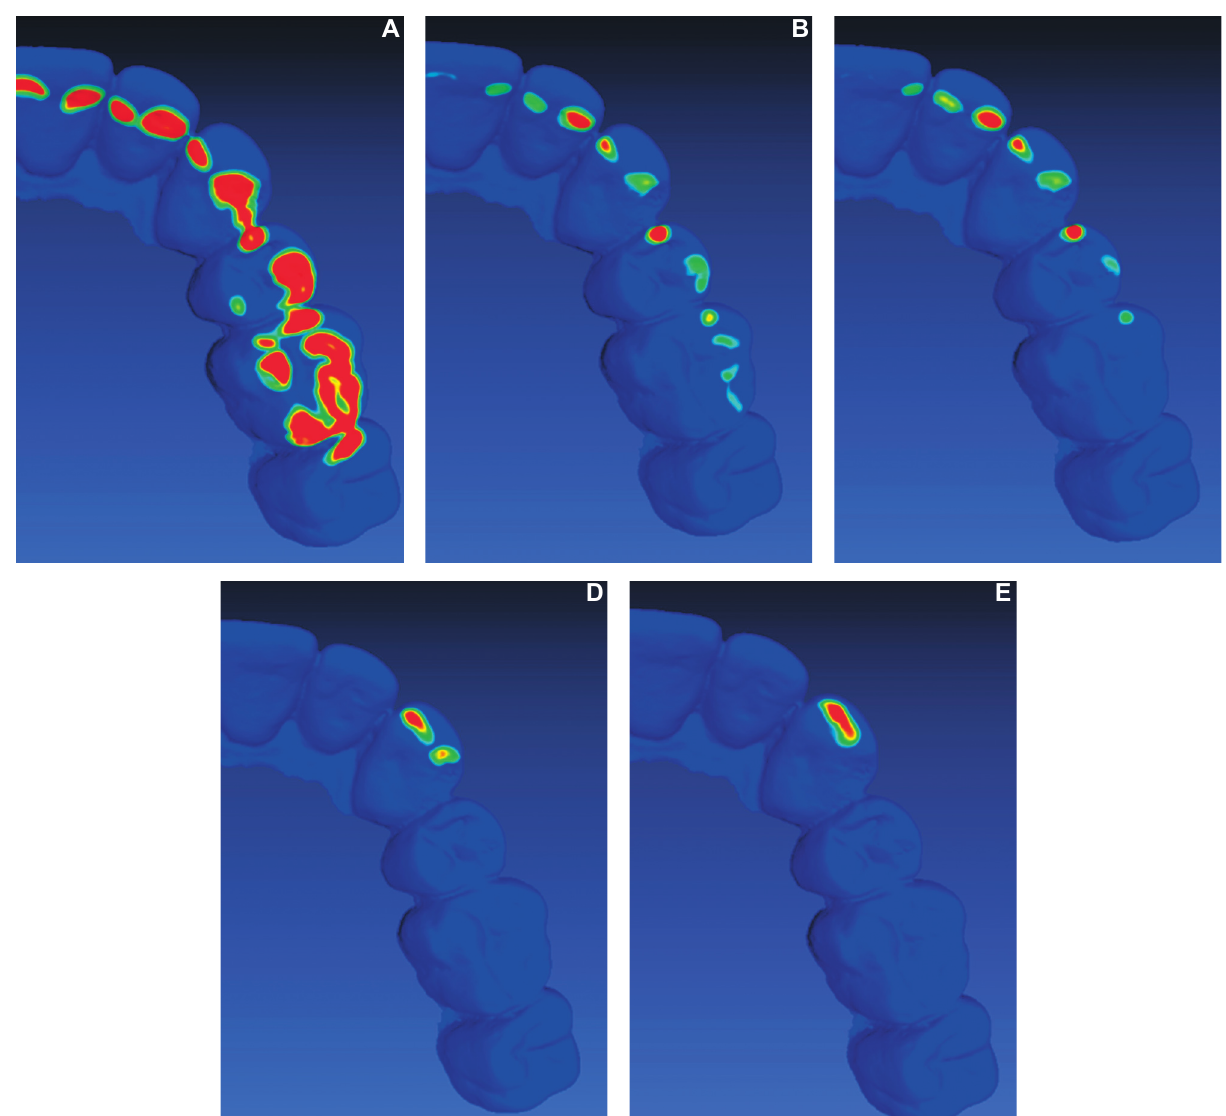
Figure 3- Example of virtual simulation of lateral movement. (A) Maximal intercuspation; (B) 0.5 mm excursion; (C) 1.0 mm excursion; (D) 2.0 mm excursion; (E) 3.0 mm excursion; red colour indicates the existing